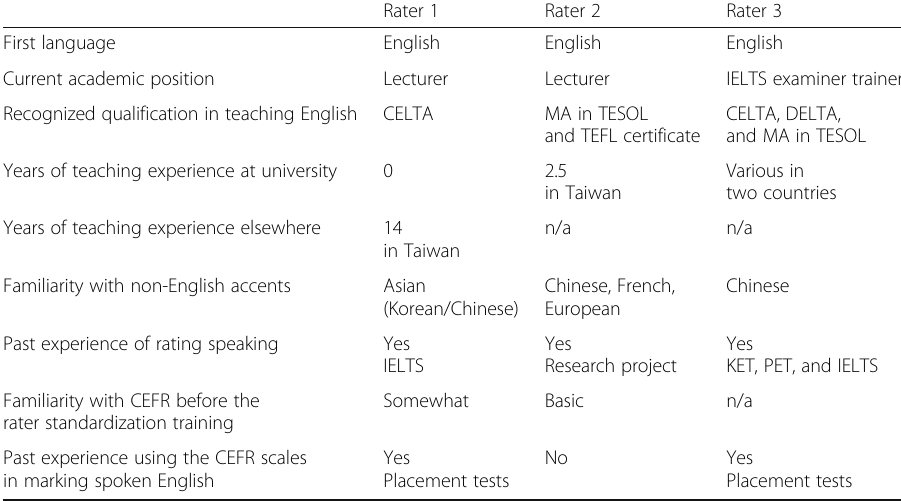
Table 1 Educational background and teaching experience of the trained